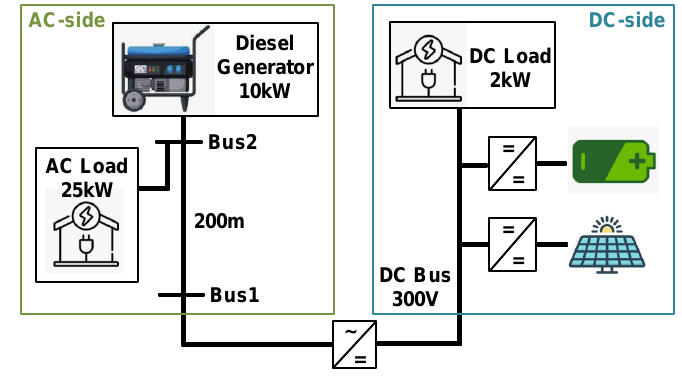
Figure 18. The framework of a small-scale hybrid microgrid.